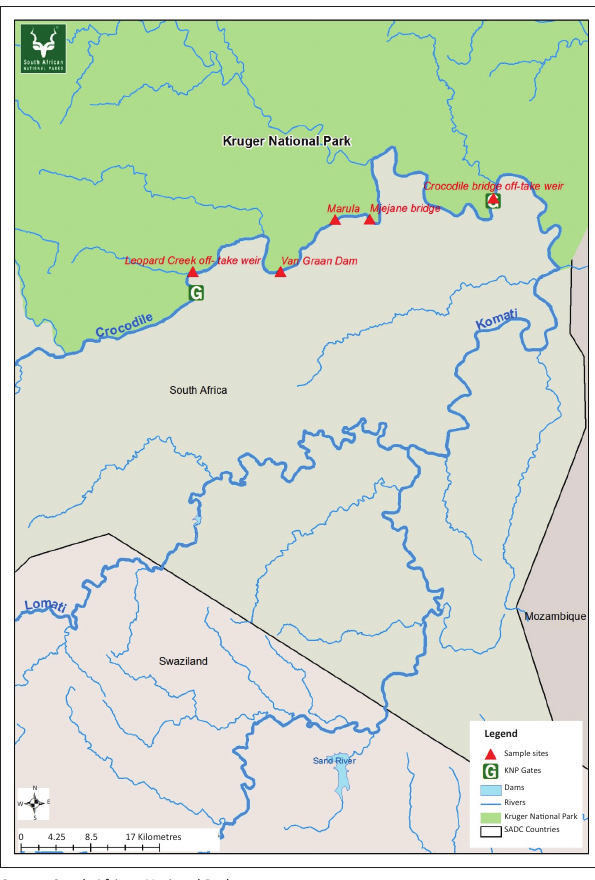
FIGURE 1: Map showing the location of the sites sampled in this study.